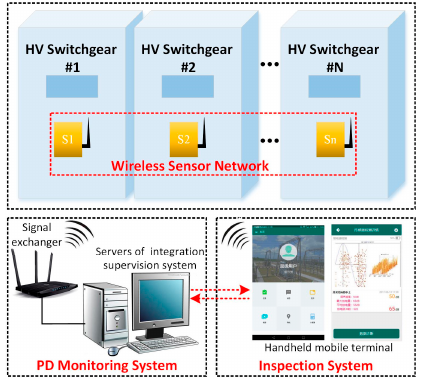
Figure 14. Application strategy of the wireless TEV sensor.